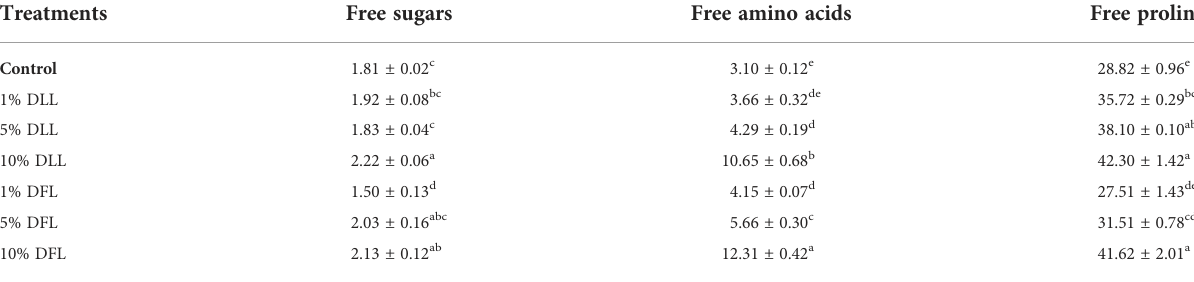
TABLE 6 Free sugars, free amino acids (mg g -1 fr wt) and free proline ( m mol g -1 fr wt) contents in leaves of Triticum aestivum L. plants raised using sand substrate (25 DAS) treated with leachates of dry leaves and fl owers of Tagetes erecta L. Treatments